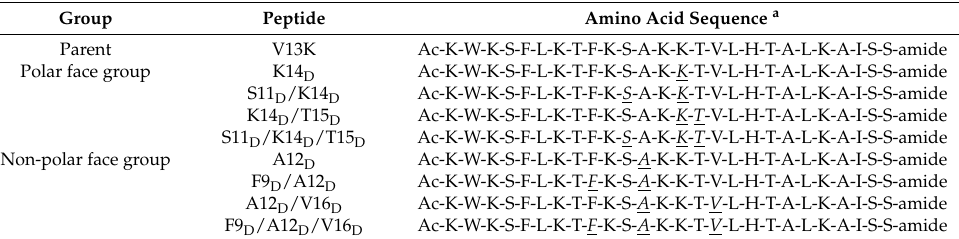
Table 1. Design and sequence of α -helical antimicrobial peptides.